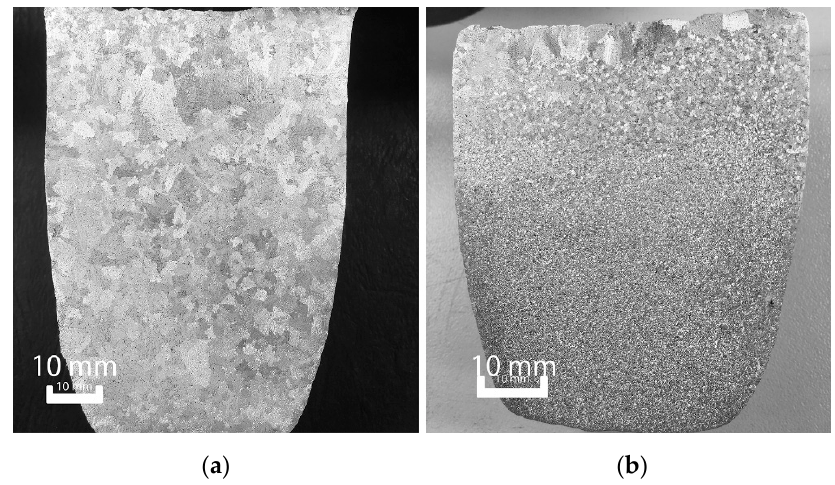
Figure 3. Macrostructure comparison ( a ) without and ( b ) with UST applied to the Al–5Mg